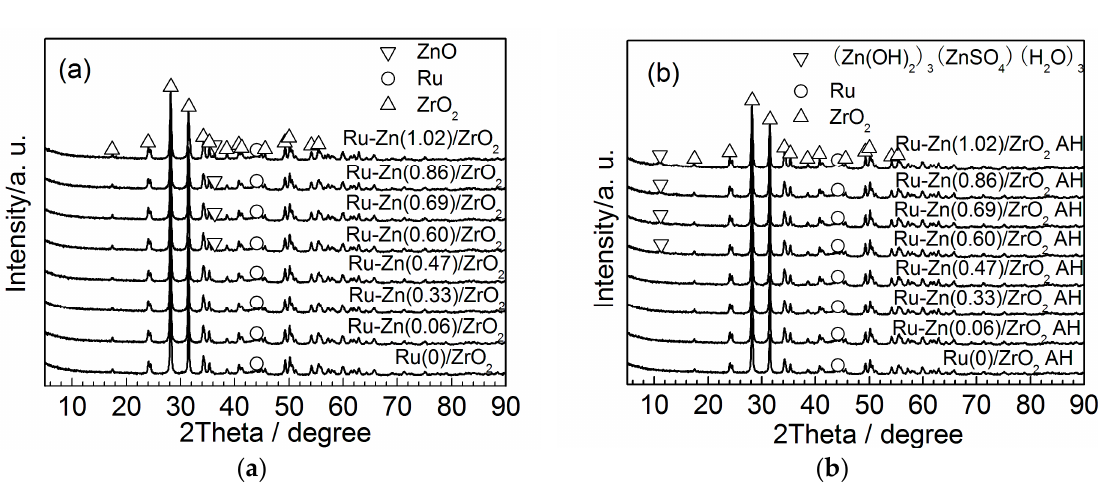
Table 1. Composition and texture properties of Ru-Zn(x)/m-ZrO 2 catalysts before and after hydrogenation, as well as pH values of the slurry after catalytic experiments.